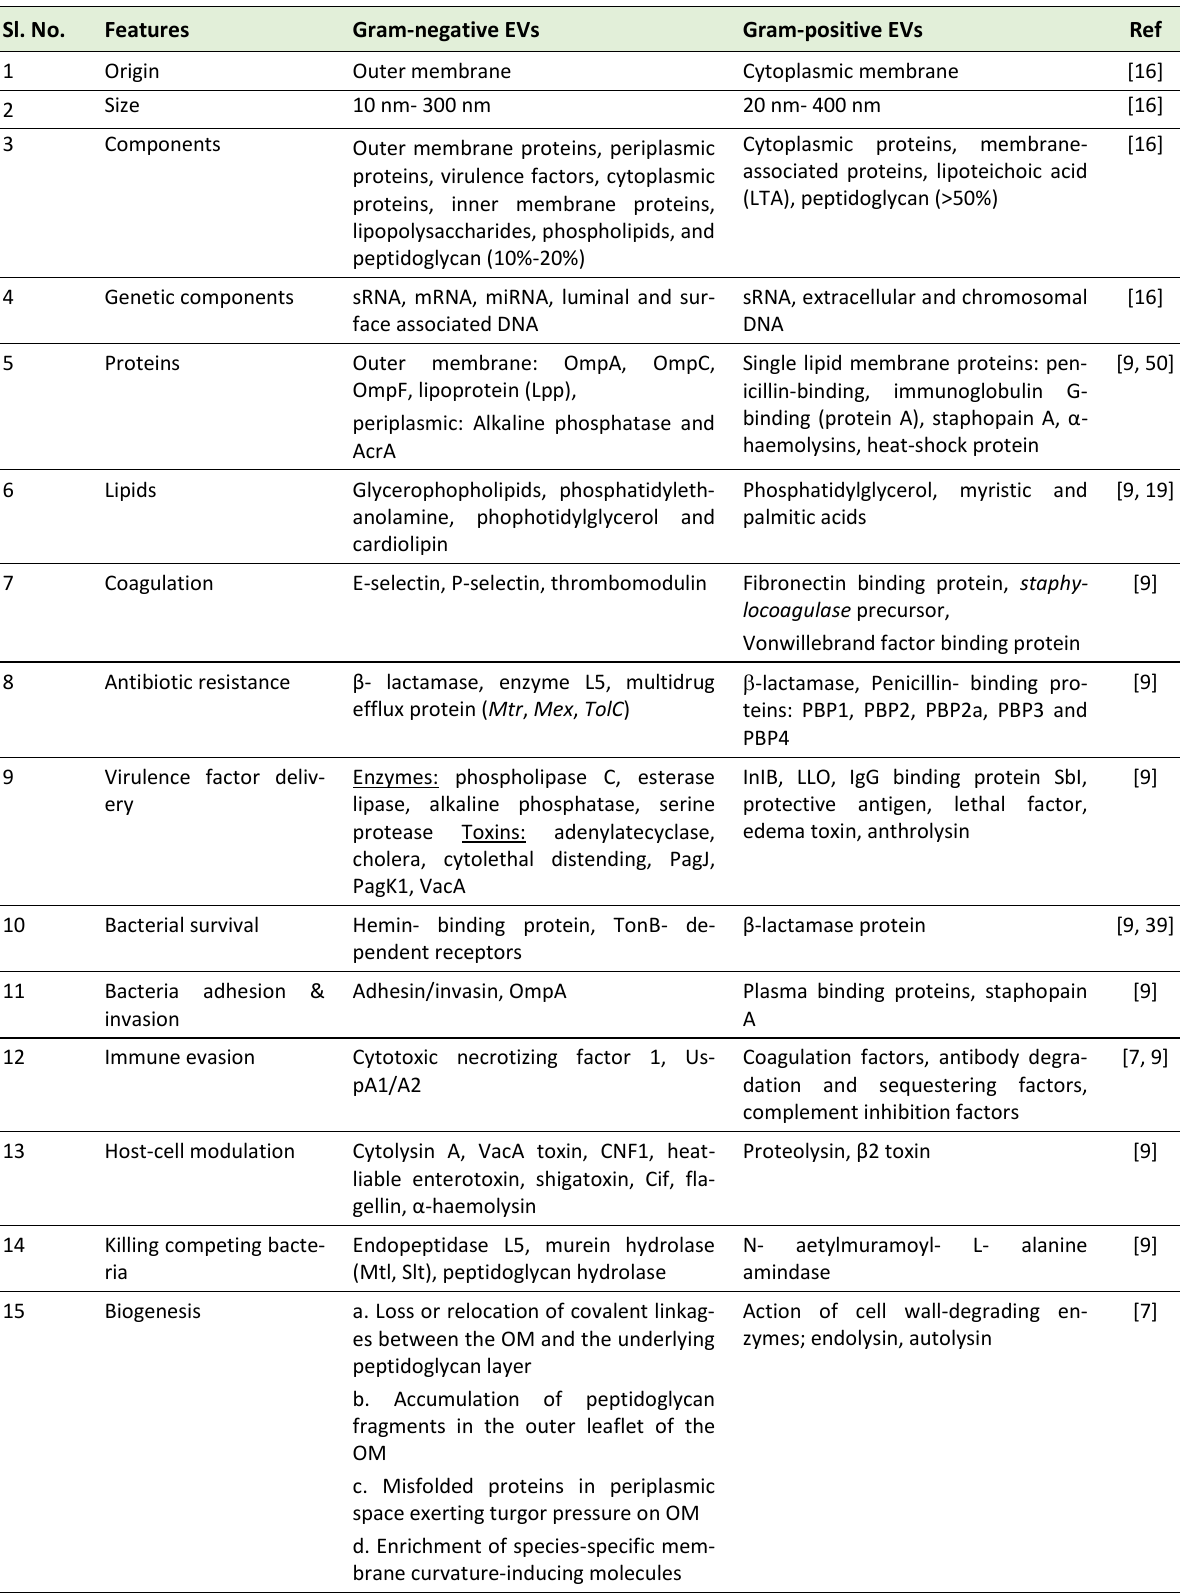
TABLE 1. Comparison between gram-negative and gram-positive extracellular vesicles. Sl.